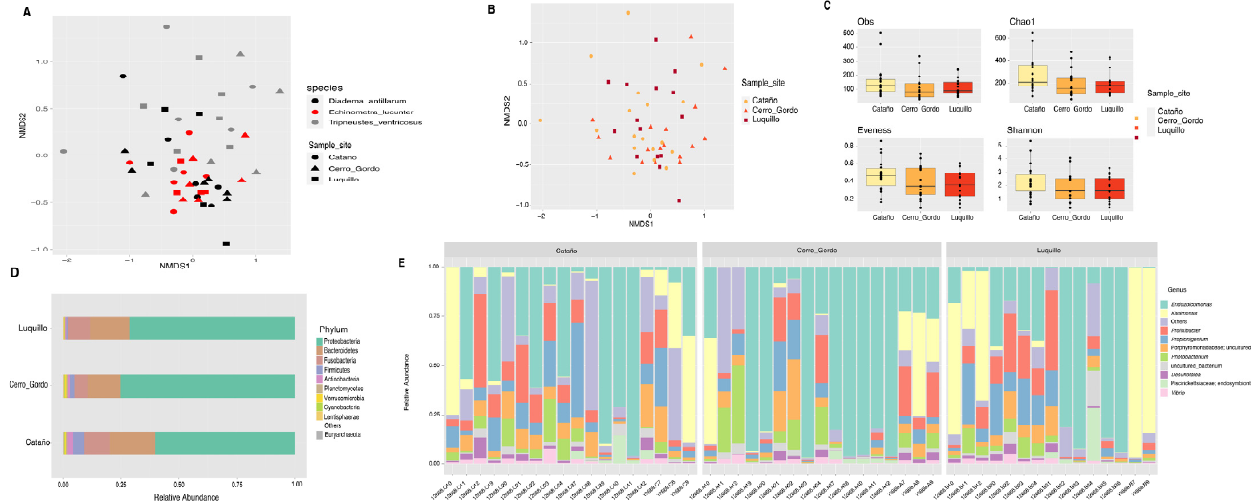
Figure 5. Spatial diversity analyses of spine microbiota comparing animals collected in Cataño, Cerro Gordo, and Luquillo. NMDS plot depicting a combination of species and sample locations shows that differences are due to the species at each location ( A ); for p-values, see supplementary Table S2. Bray–Curtis analysis, represented by an NMDS (stress = 0.1943), used sites and sea urchin species as metadata categories. ANOSIM shows no significant differences between sample sites ( B ). No alpha diversity estimates show any significant differences between sample sites ( C ). Species relative abundance of top ten taxa at phyla ( D ) and genus levels ( E ) are depicted by the bar